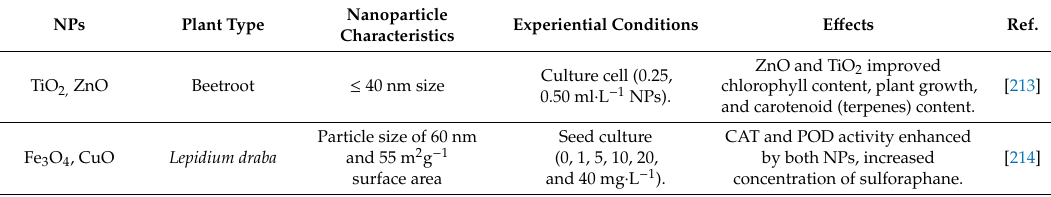
Table 6. Multiple findings toward metabolomic e ff ects in plant due to metal oxide NPs treatment. NPs Plant